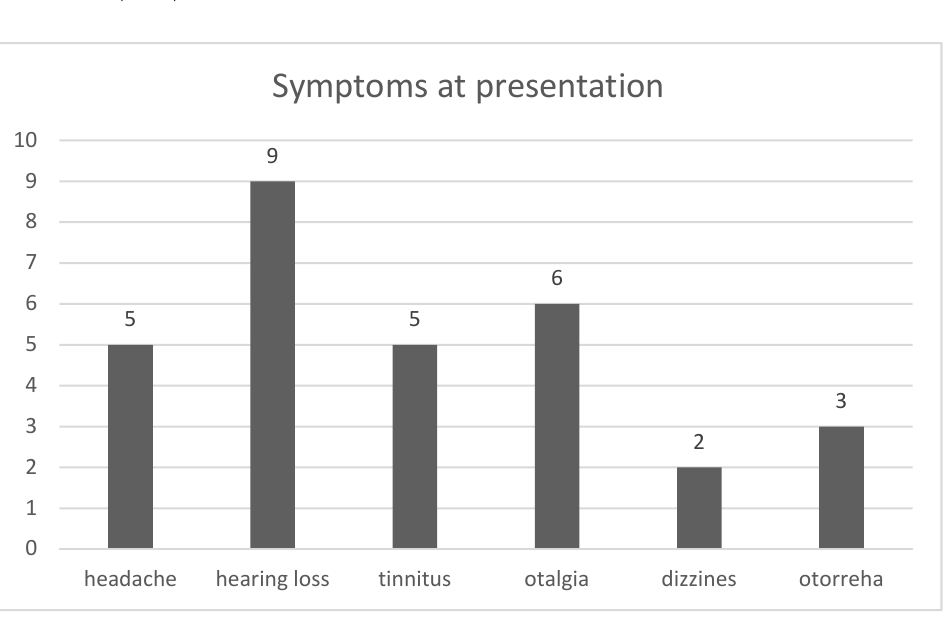
Figure 5. Biopsy of left mastoid—case 2. Hematoxylin and eosin (H&E). Original magnification: A- D 100×, E 200×. ( A ) Fibrous tissue with (top) foci of dense lymphoplasmacytic inflammation and (bottom) storiform fibrosis (H&E, original magnification 100×). ( B ) Total IgG and ( C ) IgG4 plasma cell population (original magnification 400×).